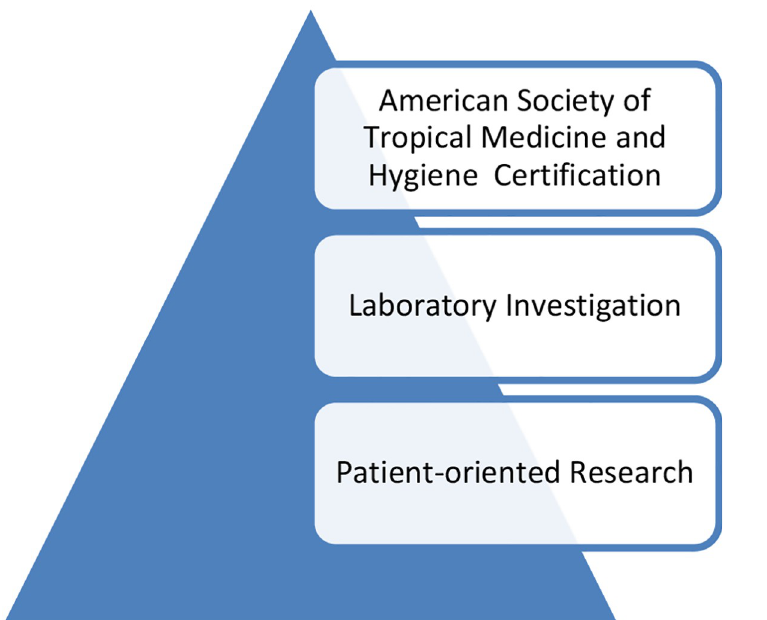
Fig 1. Training pathways for pediatric tropical